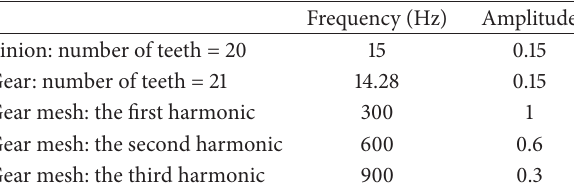
Table 1: Geared system data of the simulated signal.